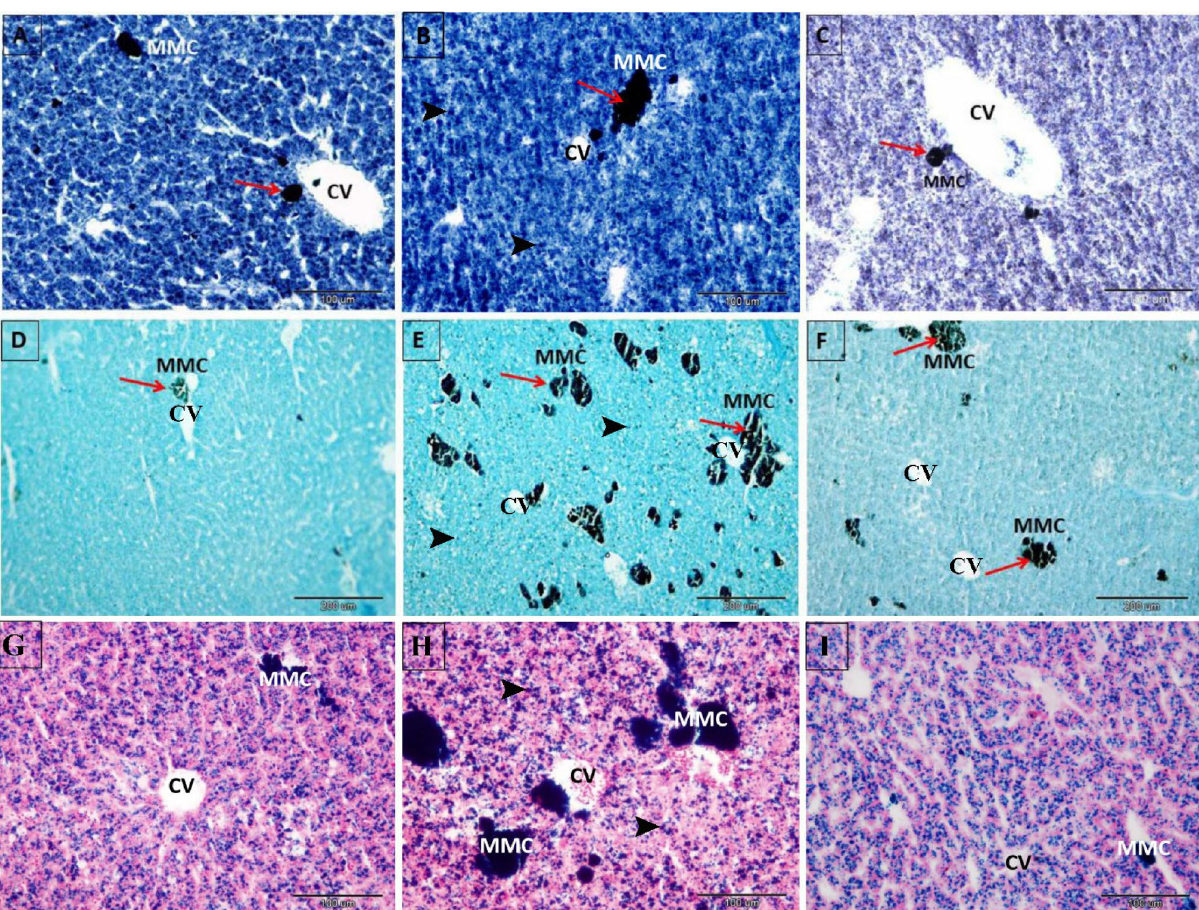
Figure 3. Photomicrograph of paraffin-embedded sections illustrating the hepatoprotective effects of NSS against 4-NP-induced hepatic MMCs disturbance in Clarias gariepinus . ( A ) Liver of control Clarias gariepinus showing a less amount of Sudan black B-positive MMCs (arrow). ( B ) Liver of 4-NP-intoxicated Clarias gariepinus showing an increase in the amount of Sudan black B-positive MMCs (arrow). ( C ) Liver of 2.5% NSS treated Clarias gariepinus showing a fewer Sudan black B-positive MMCs. Note the central vein (CV) and the abundant Sudan black-positive lipofuscin pigments (arrowheads) that filled the hepatocytes of 4-NP-intoxicated Clarias gariepinus compared to the control group and the NSS + 4-NP treated group. ( D ) The liver of control Clarias gariepinus contains a fewer Nile blue-positive MMCs (arrow). ( E ) The liver of 4-NP-intoxicated Clarias gariepinus demonstrates an increase in Nile blue-positive MMCs (arrow) surrounding the central vein (CV). ( F ) Liver of 2.5% NSS treated Clarias gariepinus showing a decline in the amount of Nile blue-positive MMCs (arrow) similar to control liver. Note the central vein (CV) and the abundant Nile blue-positive lipofuscin pigments (arrowheads) that filled the hepatocytes of 4-NP-intoxicated Clarias gariepinus compared to the control and NSS + 4-NP treated groups. ( G ) The liver of the control group displayed a small number of Prussian blue-positive MMCs of small size. ( H ) The 4-NP-intoxicated group’s liver contains numerous large Prussian blue-positive MMCs. ( I ) The liver of the 2.5% NSS + 4-NP-treated group reveals a small number of Prussian blue-positive MMCs of small size. Note the central vein (CV) and the abundant Prussian blue-positive hemosiderin pigments (arrowheads) that filled the hepatocytes of 4-NP-intoxicated Clarias gariepinus compared to the control group and the NSS + 4-NP treated group. Scale bar in ( A – C , G – I ) = 100 μm; ( D – F ) = 200 μm. ( A – C ) were stained with Sudan black B and Haematoxylin stain, ( D – F ) were stained with Nile blue stain, and G, H and I were stained with Perls’ Prussian blue cated fish (Figs. 6B,E, 7B). In contrast, the hepatocytes of the NSS + 4-NP-treated group exhibited euchromatic nuclei, nearly healthy rough and smooth endoplasmic reticulum and mitochondria. In addition, the liver of the NSS + 4-NP-treated group contained lymphocytes, peroxisomes, phagocytic vacuole, and a significant number of lysosomes (Figs. 6C,F, 7C). The colored transmission electron photomicrographs (Figs. 6, 7) and negative images (Fig. 8) of Fig. 6 were employed to determine the cytoprotective effect of NSS against 4-NP-induced hepatocellular damage in Clarias gariepinus.